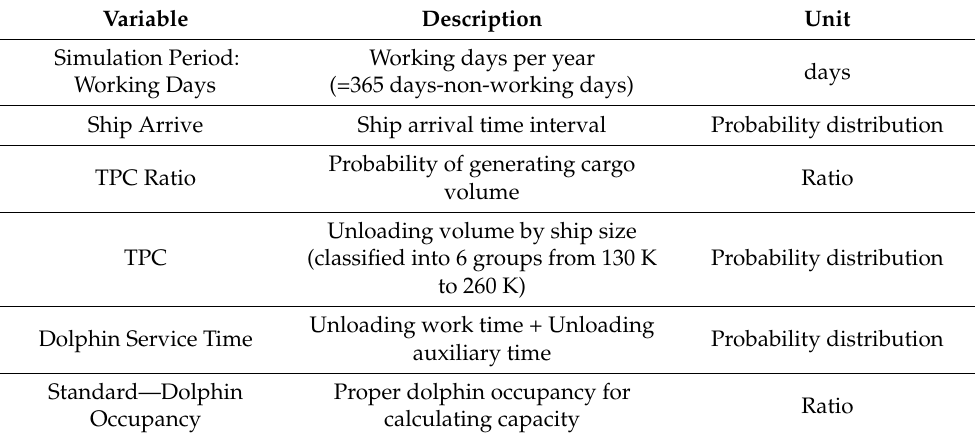
Table 2. Input variables for the simulation model.